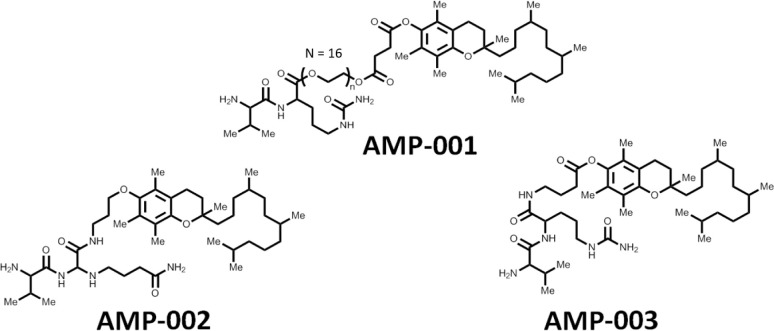
Structures of AMP-001, AMP-002 and AMP-003.